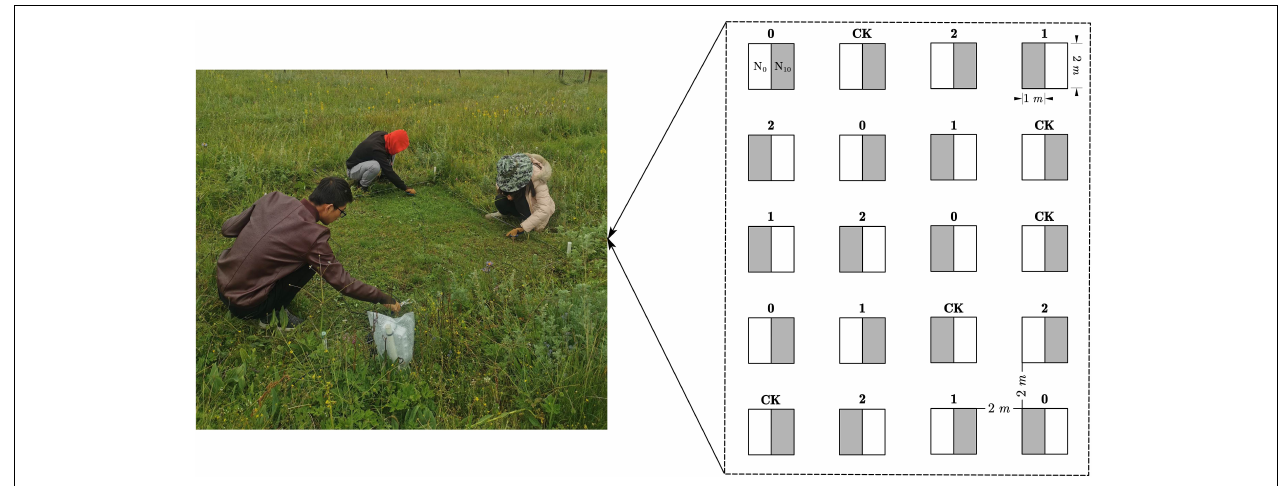
FIGURE 1 | Schematic representation of the experiment design. Twenty 2 × 2 m plots were laid out in four columns and five rows with a 2 m-wide buffer zone between the plots. Labels above the boxes represent the clipping treatments that were randomly assigned to the plots (CK: no clipping; 0: high intensity; 1: moderate intensity; 2: low intensity). Each 2 × 2 m plot was divided into two subplots, one was dedicated to the ambient N (N 0 , subplot A white), another to nitrogen addition treatment (N 10 , subplot B gray).